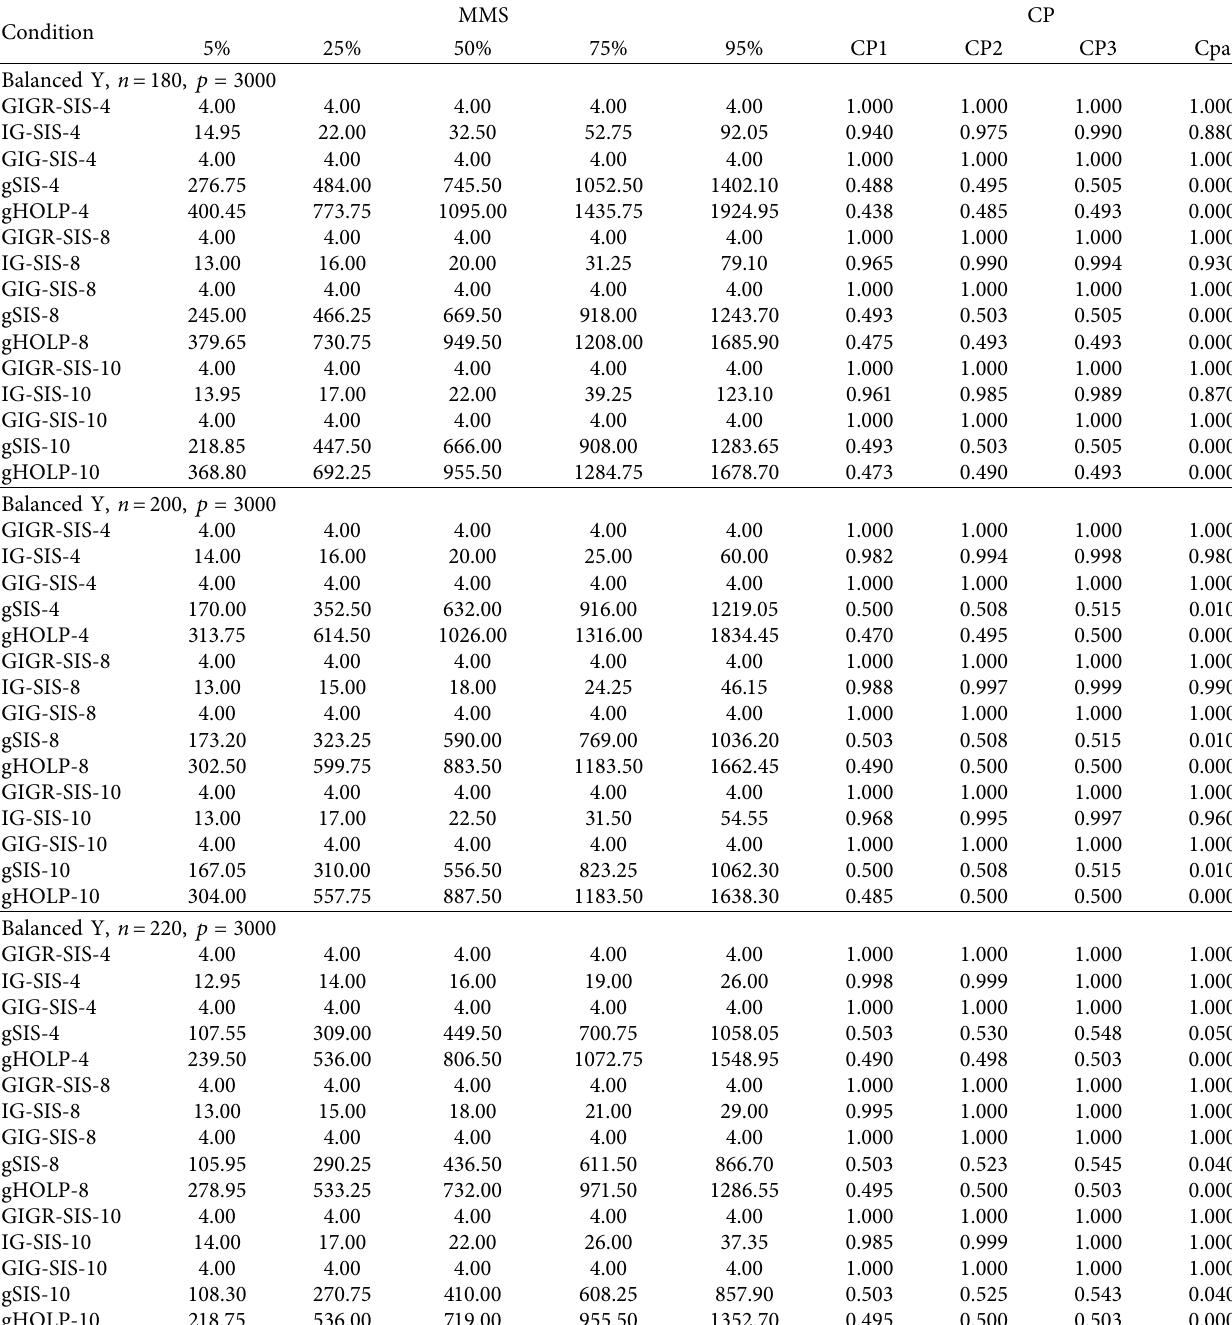
Table 4: Simulation results for Model 3: balanced